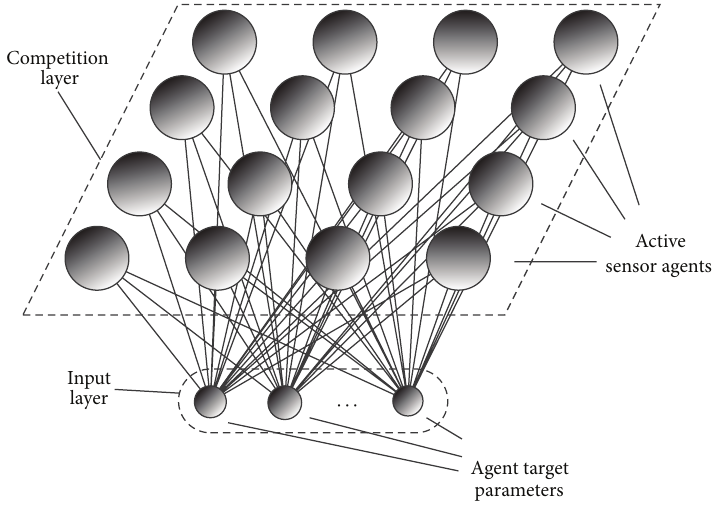
Figure 2: SOM for autonomous agents-based sensory